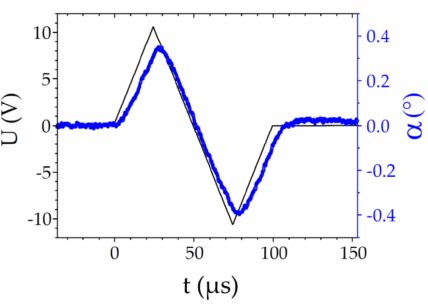
Figure 6. CB6OCB at T = 108.05 ◦ C: Time-evolution of the electroclinic tilt angle α (blue open symbols, right axis) subject to a triangular voltage pulse (black line, left